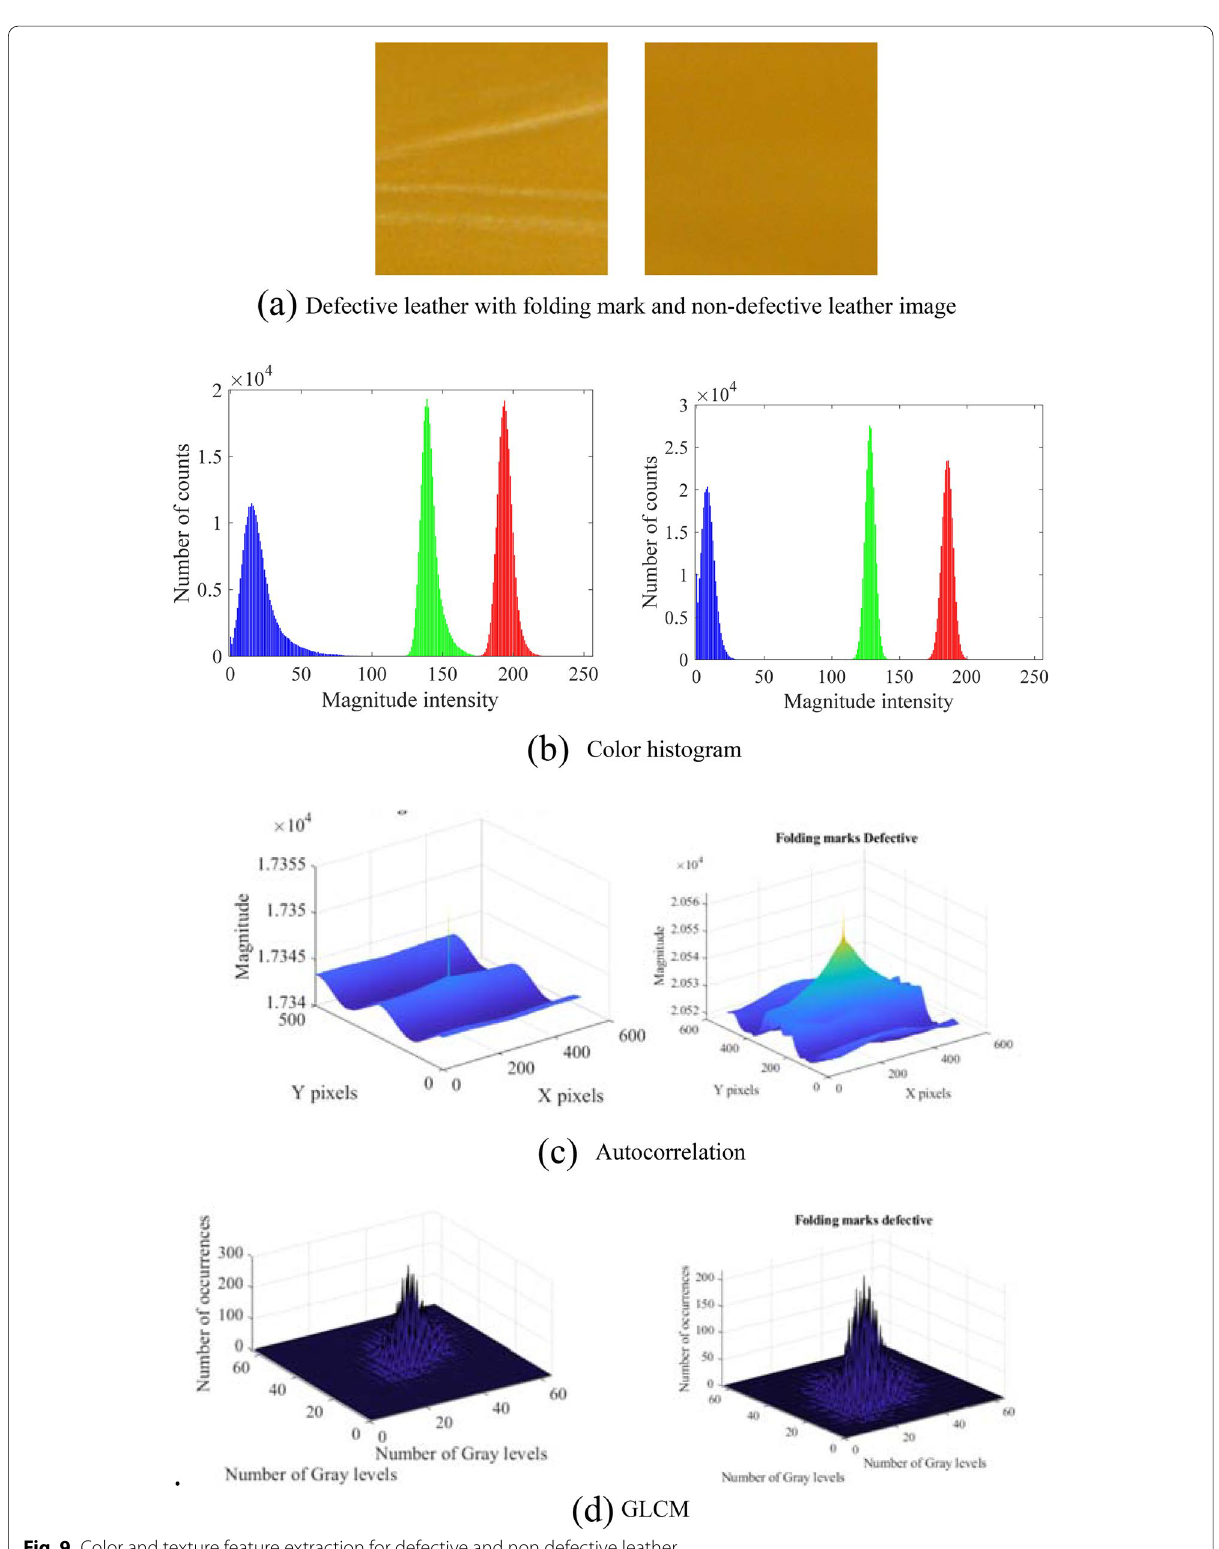
Fig. 9 Color and texture feature extraction for defective and non defective